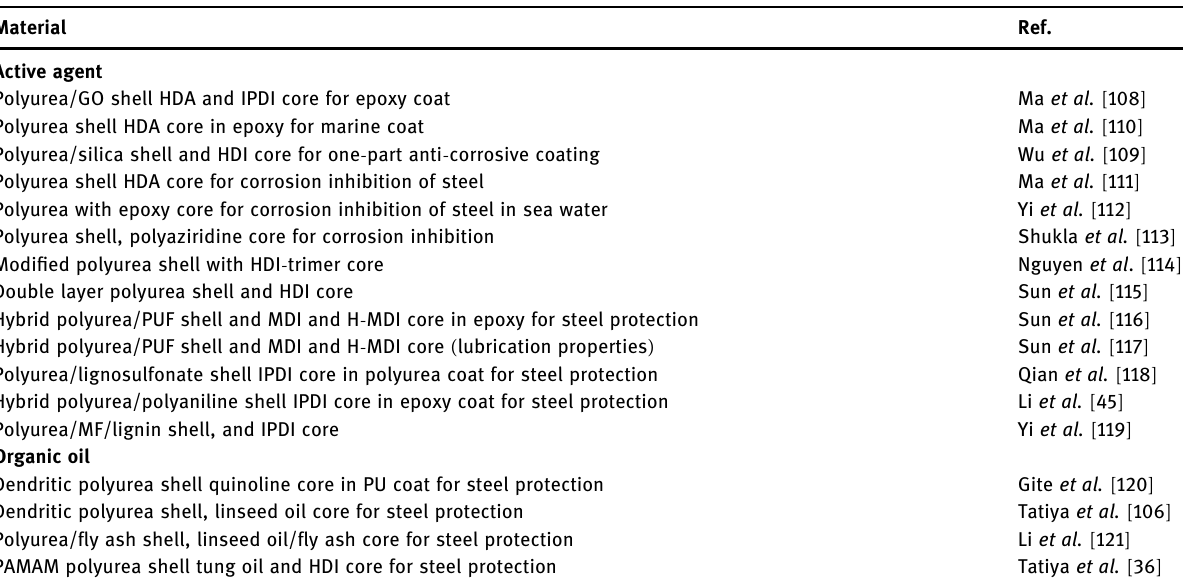
Table 4: Summary of polyurea micro - /nano - capsule application for self - healing of polymeric materials Material